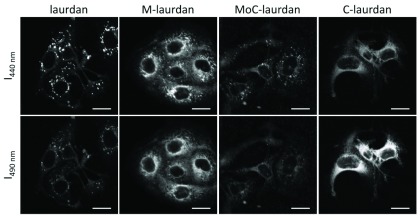
Fluorescence emission spectra recorded at 440 and 490 nm using the Zeiss LSM 710 confocal spectral mode (two-photon excitation set to 720 nm).The images are recorded in one pass on the spectra detector and used to calculate GP maps (scale bar, 20 µm).